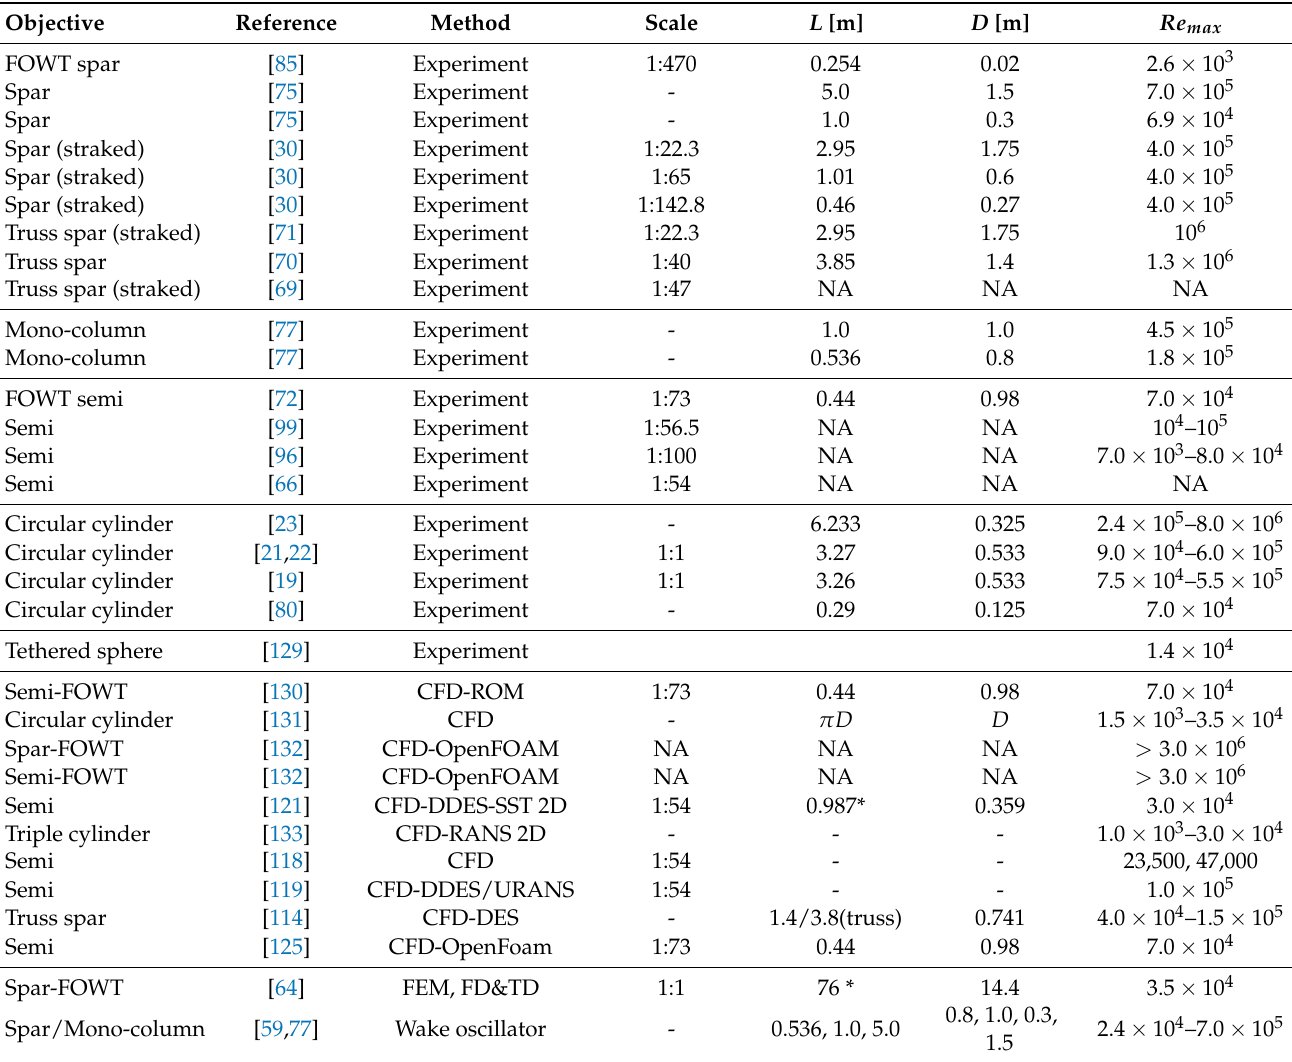
Table 4. List of selected VIM and relevant VIV